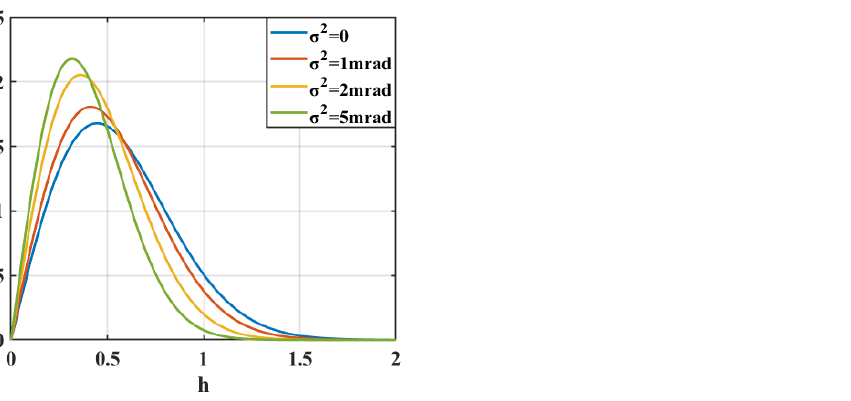
Figure 6. Normalized distribution of the channel coefficient with different wind resistances in yaw motion.